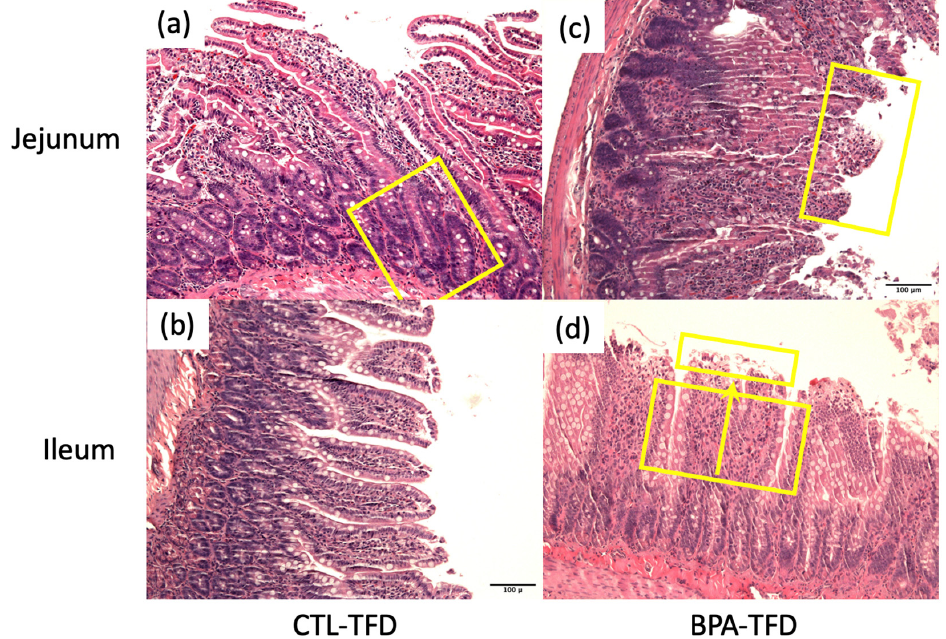
Figure 4. Representative images of the jejunum and ileum sections from adult offspring on the trans fat diet, stained with H&E (scale bars = 100 μ m). ( a , b ) Elongated crypts (yellow box) and blunted villi were found in control offspring on trans fat diet. ( c , d ) Focal broadening and shortening of villi and mucosal necrosis were observed in jejunum and ileum of BPA offspring on a trans fat diet. These changes were scattered across the different tissue sections and therefore regarded as insignificant (10 × magnification, n =